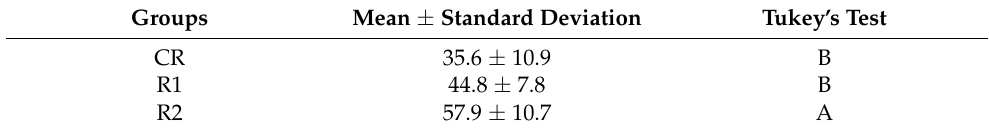
Table 6. Mean and standard deviation for the contact angle with Tukey’s test ( α = 0.05) for the